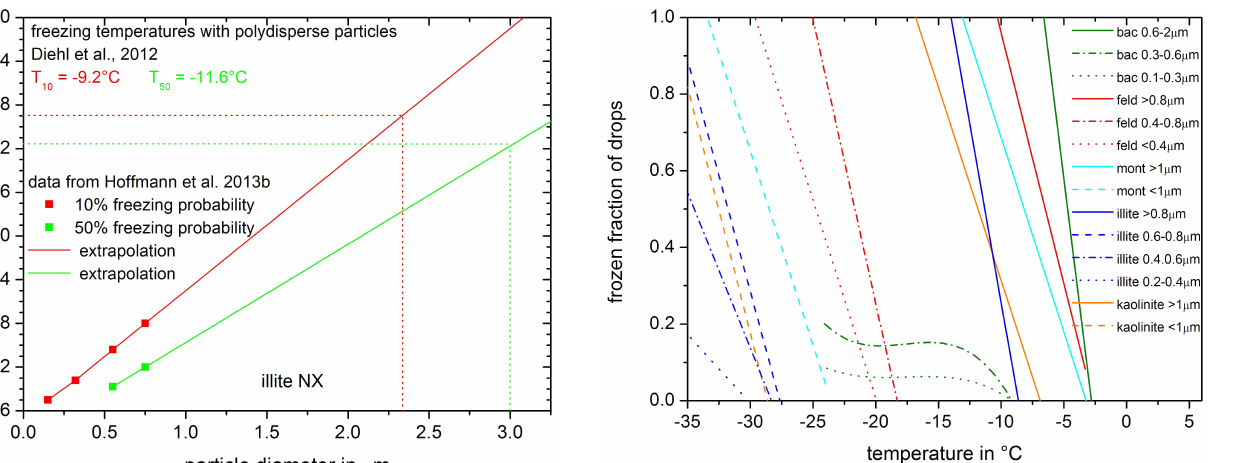
Table 2. Values of contact freezing constants in Eqs. (10) and (11). Based on data from a N. Hoffmann and A. Kiselev (personal com- munication, 2014), who used Snomax ® as a proxy for bacteria and b Levin and Yankofsky (1983). The latter values were used in Diehl et al. (2006).